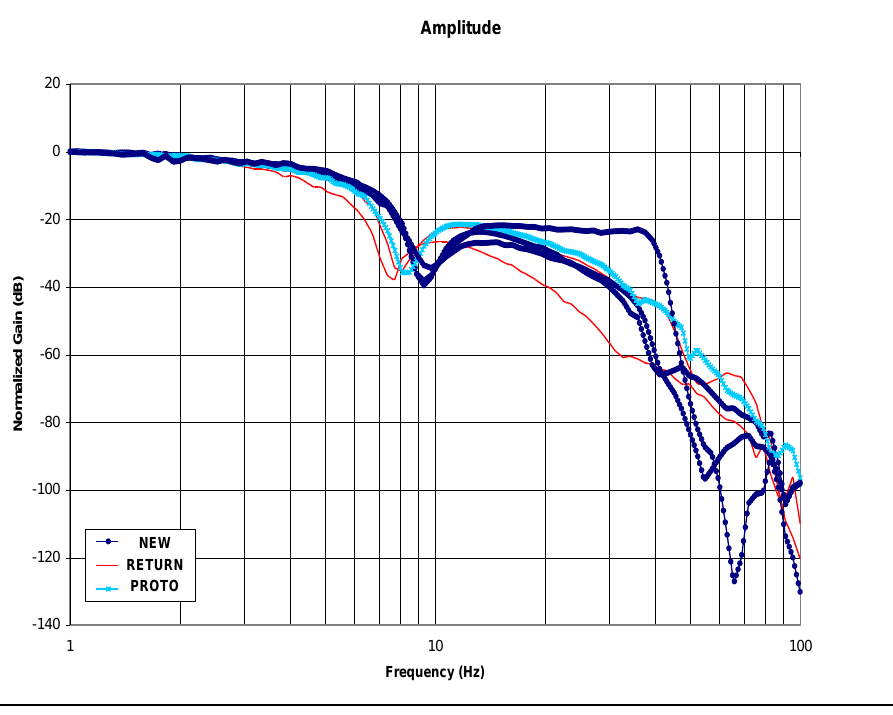
Figure 3. Normalized gains of the EFC valves with medium amplitude.